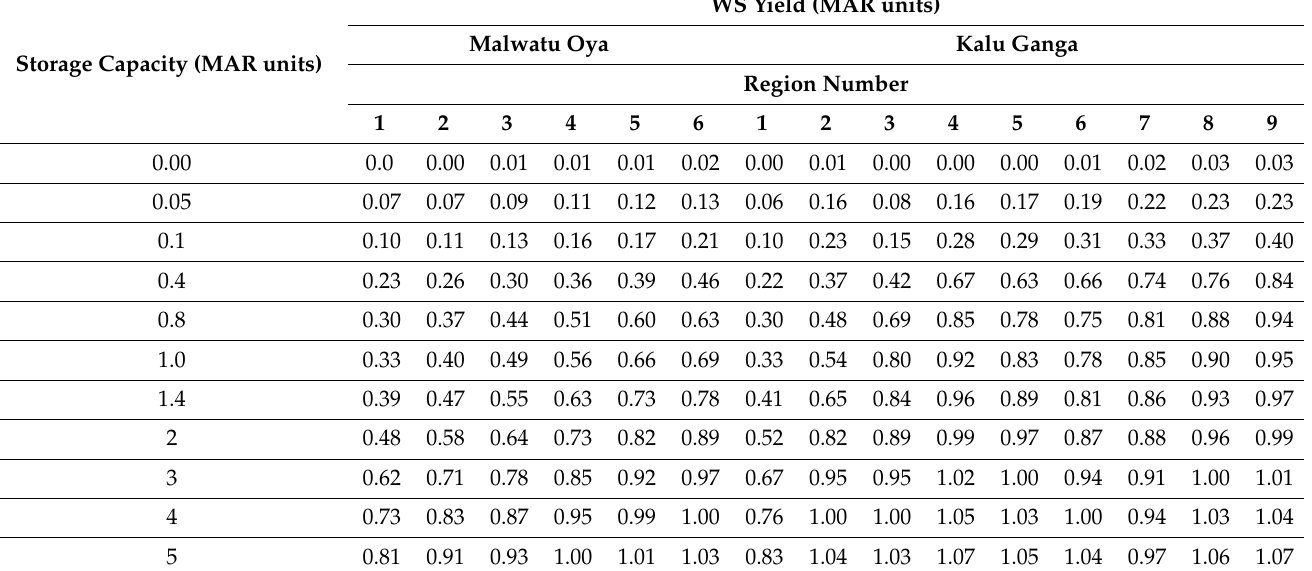
Figure 11. Regional Storage-Yield Curves of Malwatu Oya with minor sub-basins having similar curves indicated by color and number. Graphs show storage capacity on the horizontal axis; WS Yield on the vertical axis in MAR units. Table 5. Regional storage-yield curves represented as flow tables for Malwatu Oya and Kalu Ganga basins (Figure 11, Figure